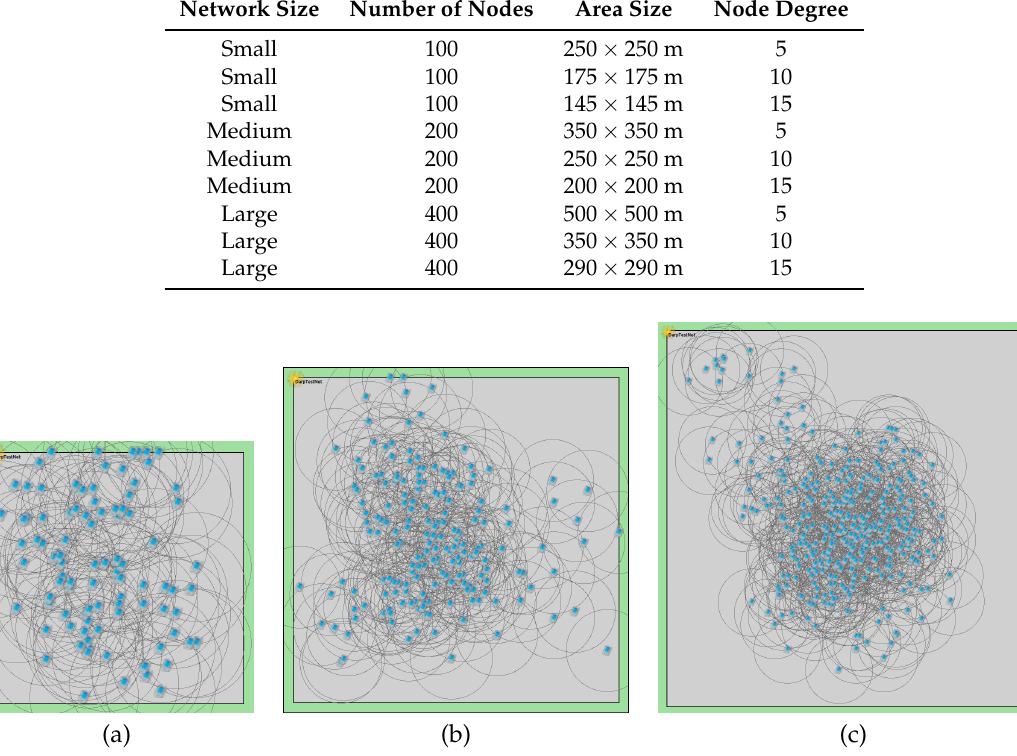
Figure 11. Samples of a small ( a ), medium ( b ), and large ( c )